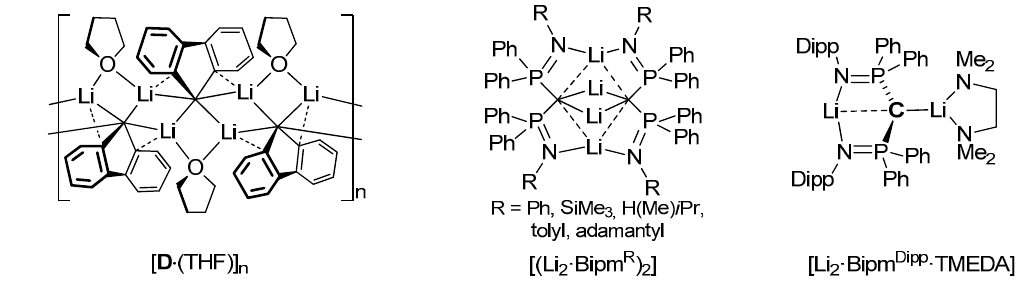
Figure 2. Structures of dilithium methandiides.